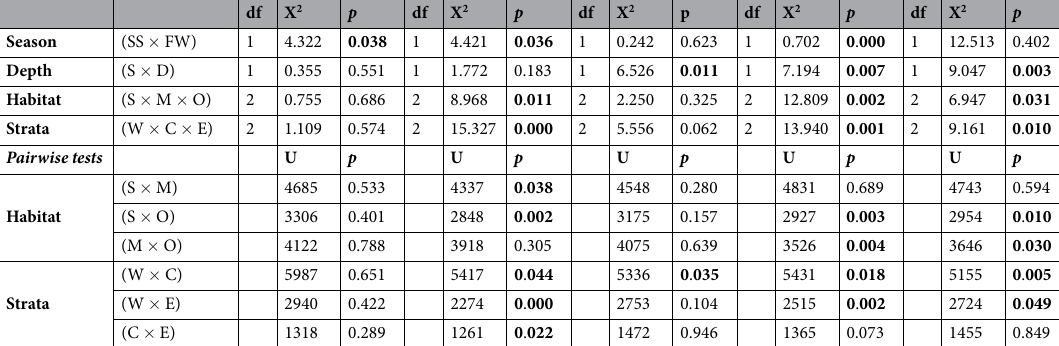
Table 3. Results of ANOVA testing the effect of Season (SS: Spring/Summer, FW: Fall/Winter), Depth (Shallow: ≤ 10 m, Deep: > 10 m), Habitat (S: Sand, M: Mud, O: Other), and Strata (W: West, C: Central, E: East) on the relative abundance of Elasmobranchs, Sharks, Rays, the Arabian carpetshark ( Chiloscyllium arabicum ) and stingrays ( Himantura spp.); df = degrees of freedom; bold p values denotes significance at p < 0.05.